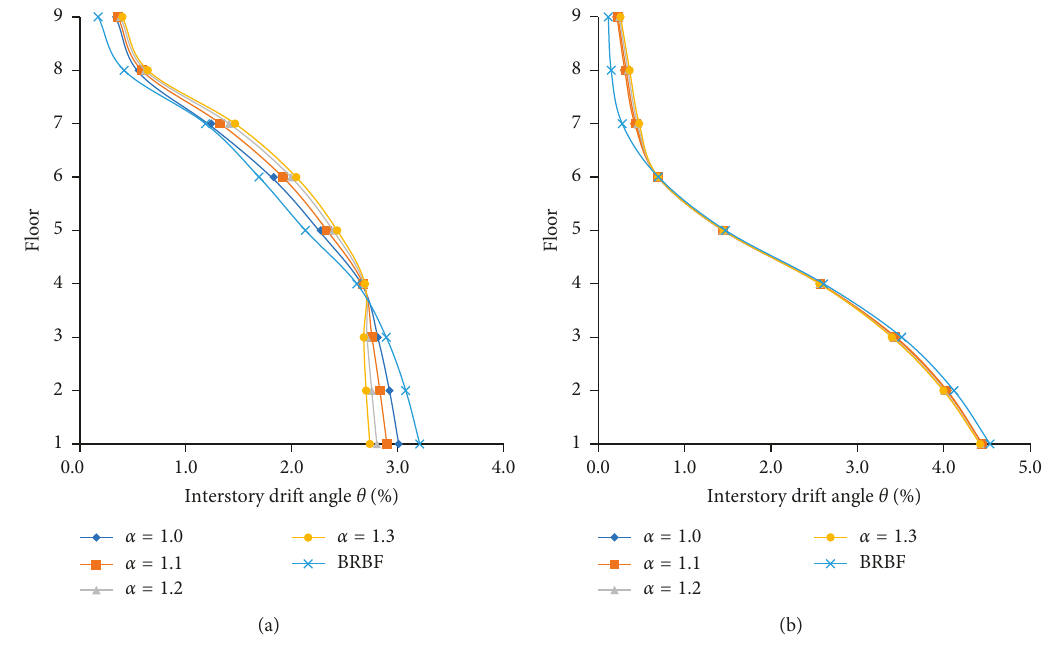
Figure 22: The effects of α on the interstory drifts of 9-story SC-TOBFs: (a) LD-1 and (b)